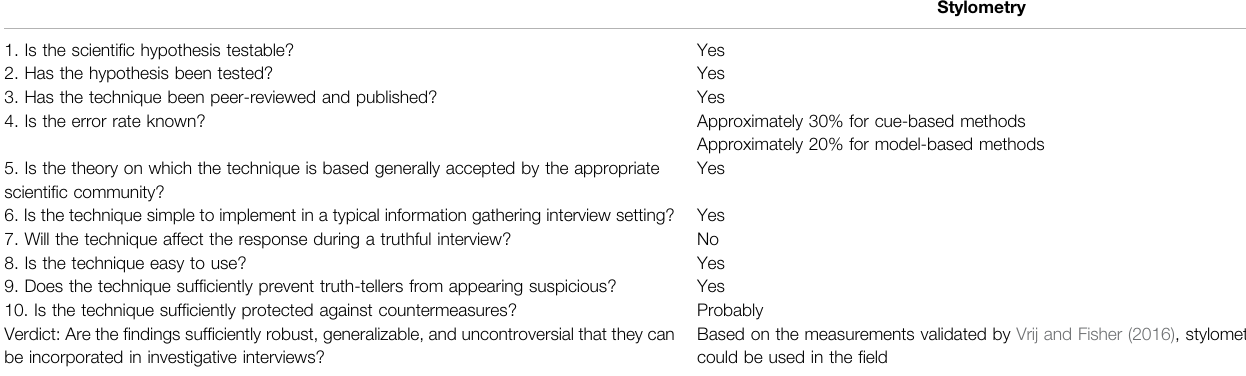
TABLE 1 | Evaluation of the applicability of stylometric methods to detect deception on the fi eld (based on Vrij & Fisher,